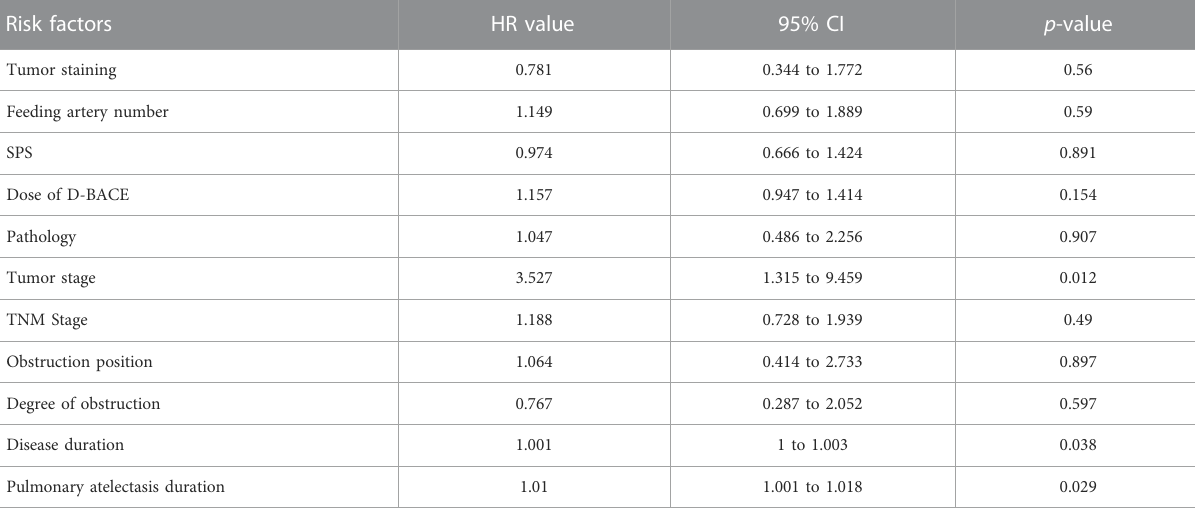
TABLE 5 Risk factors affecting DEB-BACE ef fi